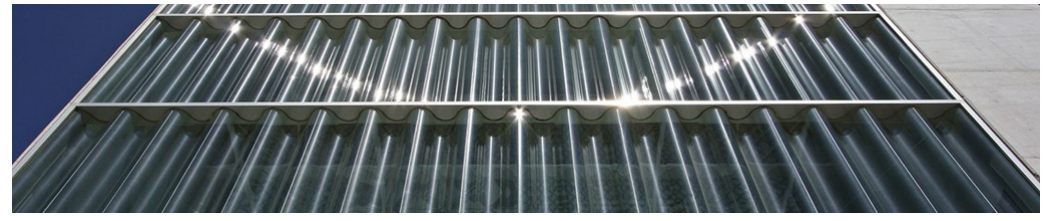
Fig. 4 Glass façade of Casa da Musica in Porto